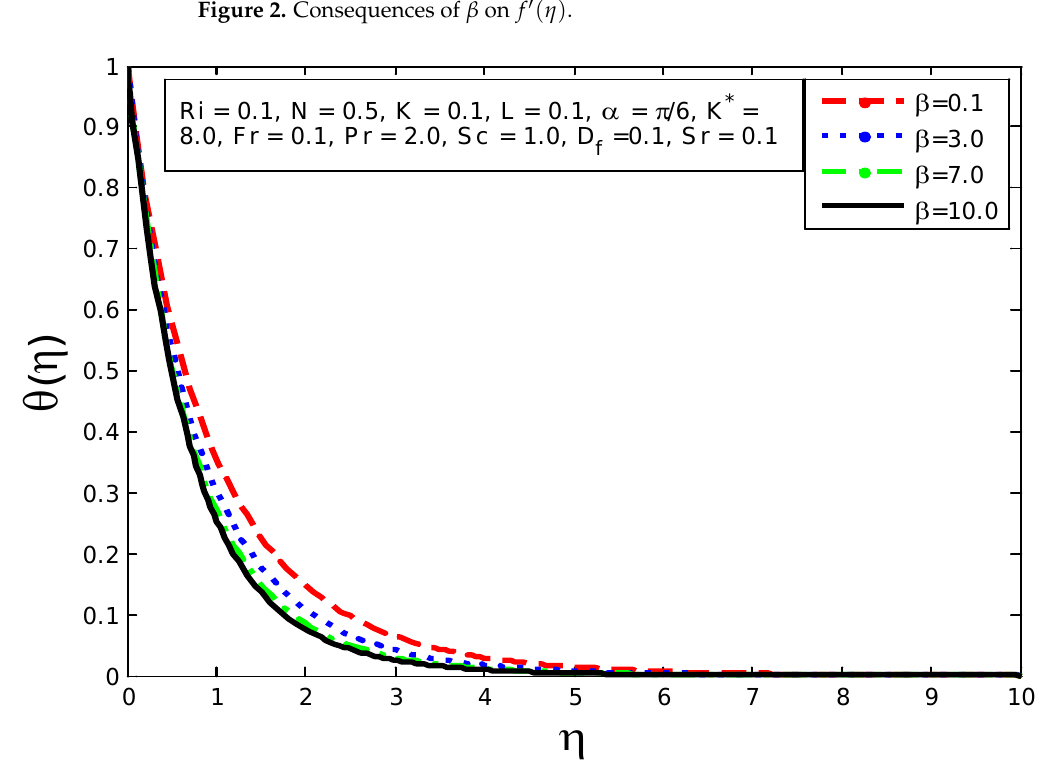
Figure 3. Consequences of β on θ ( η )